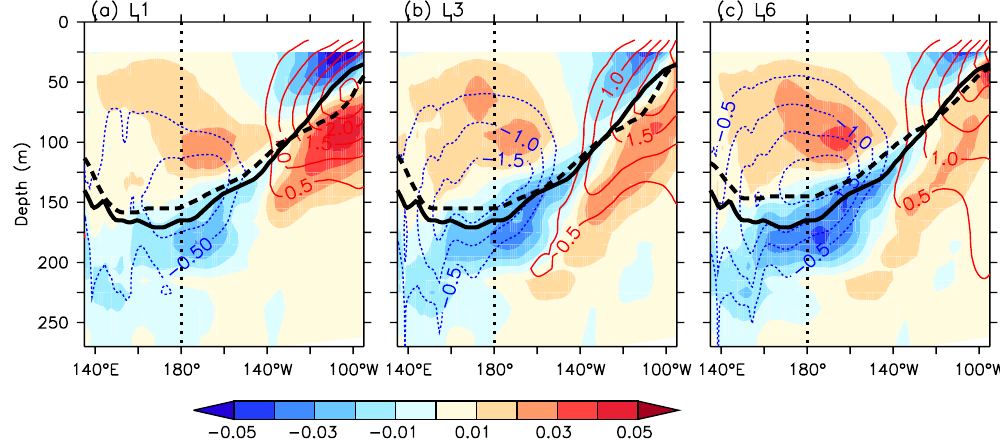
Figure 5. Tropical Pacific mean bias. Vertical cross section of difference between climatological mean ocean temperature (colored contour lines, contour interval = 0.5 °C, zero lines are removed) along the equator (2°S- 2°N) and its vertical gradients (shades, °C m − 1 ) over the hindcast periods (1983–2014) from the average of all member forecasts at ( a ) 1-, ( b ) 3-, and ( c ) 6-month lead times, and those from the GODAS reanalysis. The thermocline depth (depth of maximum temperature gradient within 0–400 m) from forecasts (thick black dashed-lines) and the observations (thick black solid-lines) are also